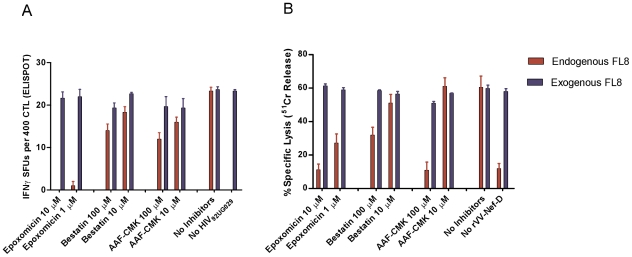
Immunoproteasomes and proteasomes are pivotal to the generation of endogenously processed FL8 epitope.In the intracellular antigen processing inhibition assay (IAPIA), HLA-B8 targets were pre-treated with Epoxomicin (immunoproteasome and proteasome inhibitor), Bestatin (aminopeptidase inhibitor) and AAF-CMK (TPPII protease inhibitor). Target cells were then infected with HIV-192UG029 for 36 hours post-infection and co-cultured with a FL8-specific CTL clone on an IFNy ELISPOT at an E∶T ratio of 400∶20000 per well (A) or infected with rVV-D for 4 hours and then co-cultured with a FL8-specific CTL clone in a chromium release assay at an E∶T ratio of 40000∶5000 per well (B). Red bars represent endogenously derived FL8 peptide for CTL recognition. Blue bars represent exogenously added synthetic FL8 peptide for CTL recognition as an internal control against inhibitor-induced cell death in infected target cells, (with blue bars in the ELISPOT standardised relative to maximum endogenous FL8 SFUs in the absence of inhibitors). The addition of each inhibitor to virally-infected cells was performed in triplicate.